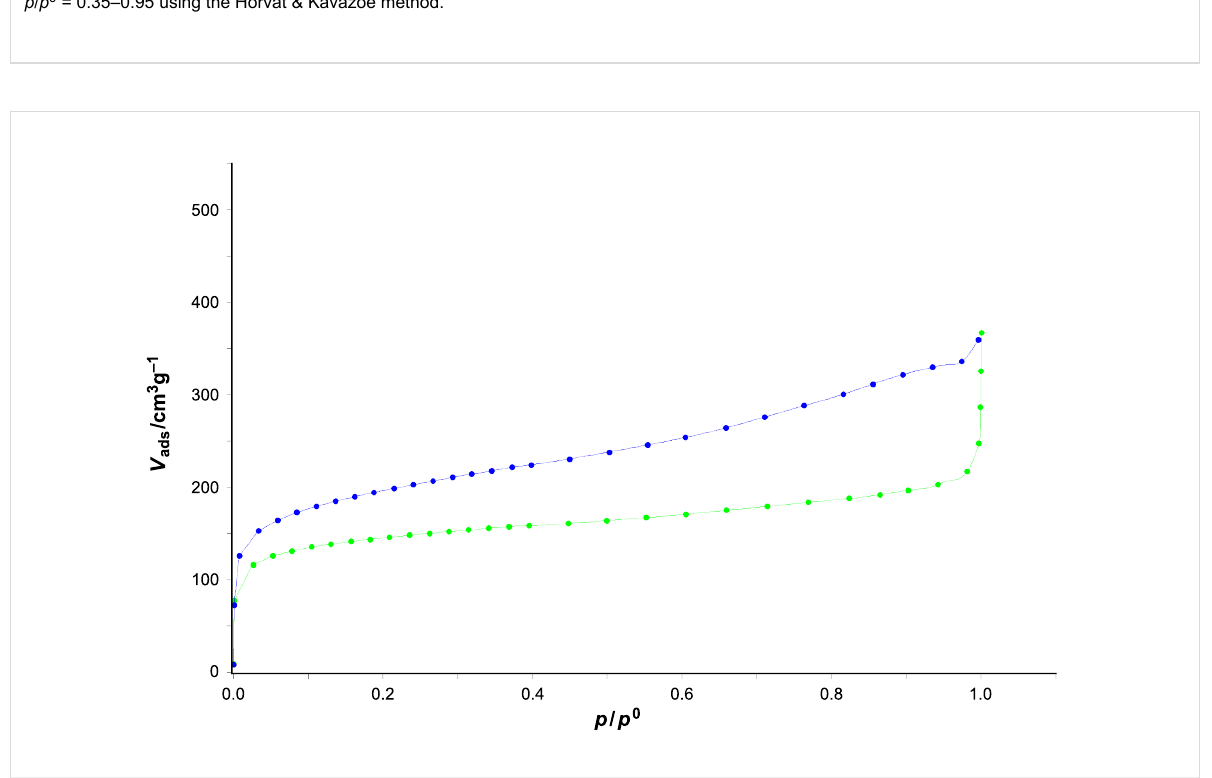
Figure 4: Adsorption isotherms of HCP 3 (green) and HCP 5 (blue) with nitrogen at 77 K. Desorption isotherms are not shown for the sake of im- proved clarity; they can be viewed in Supporting Information File 1, Figures S1 and